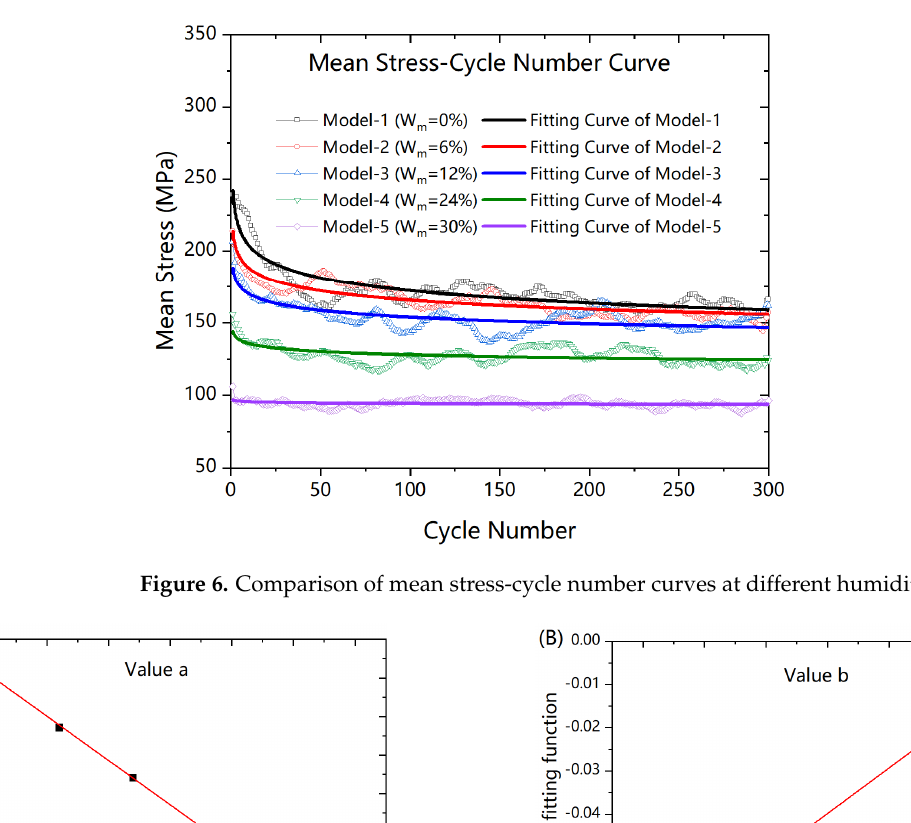
Figure 6. Comparison of mean stress-cycle number curves at different humidity.